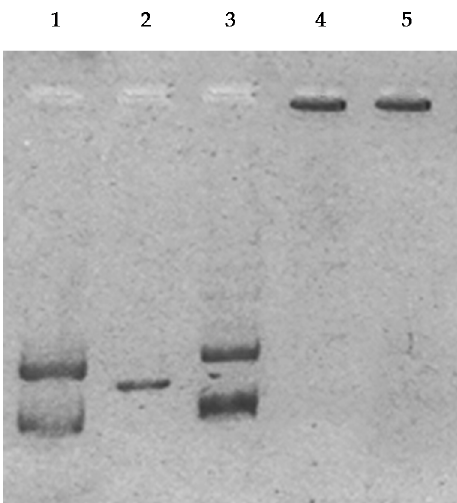
Figure 8. hTopo II inhibition assay. kinetoplast DNA (kDNA) was incubated with human topoisomerase II in the absence (lane 3, vehicle DMSO) or presence of compound AuL7 and AuL4 at1 μ M (lane 4 and 5 respectively). Lane 1 and 2, decatenated and linear kDNA,